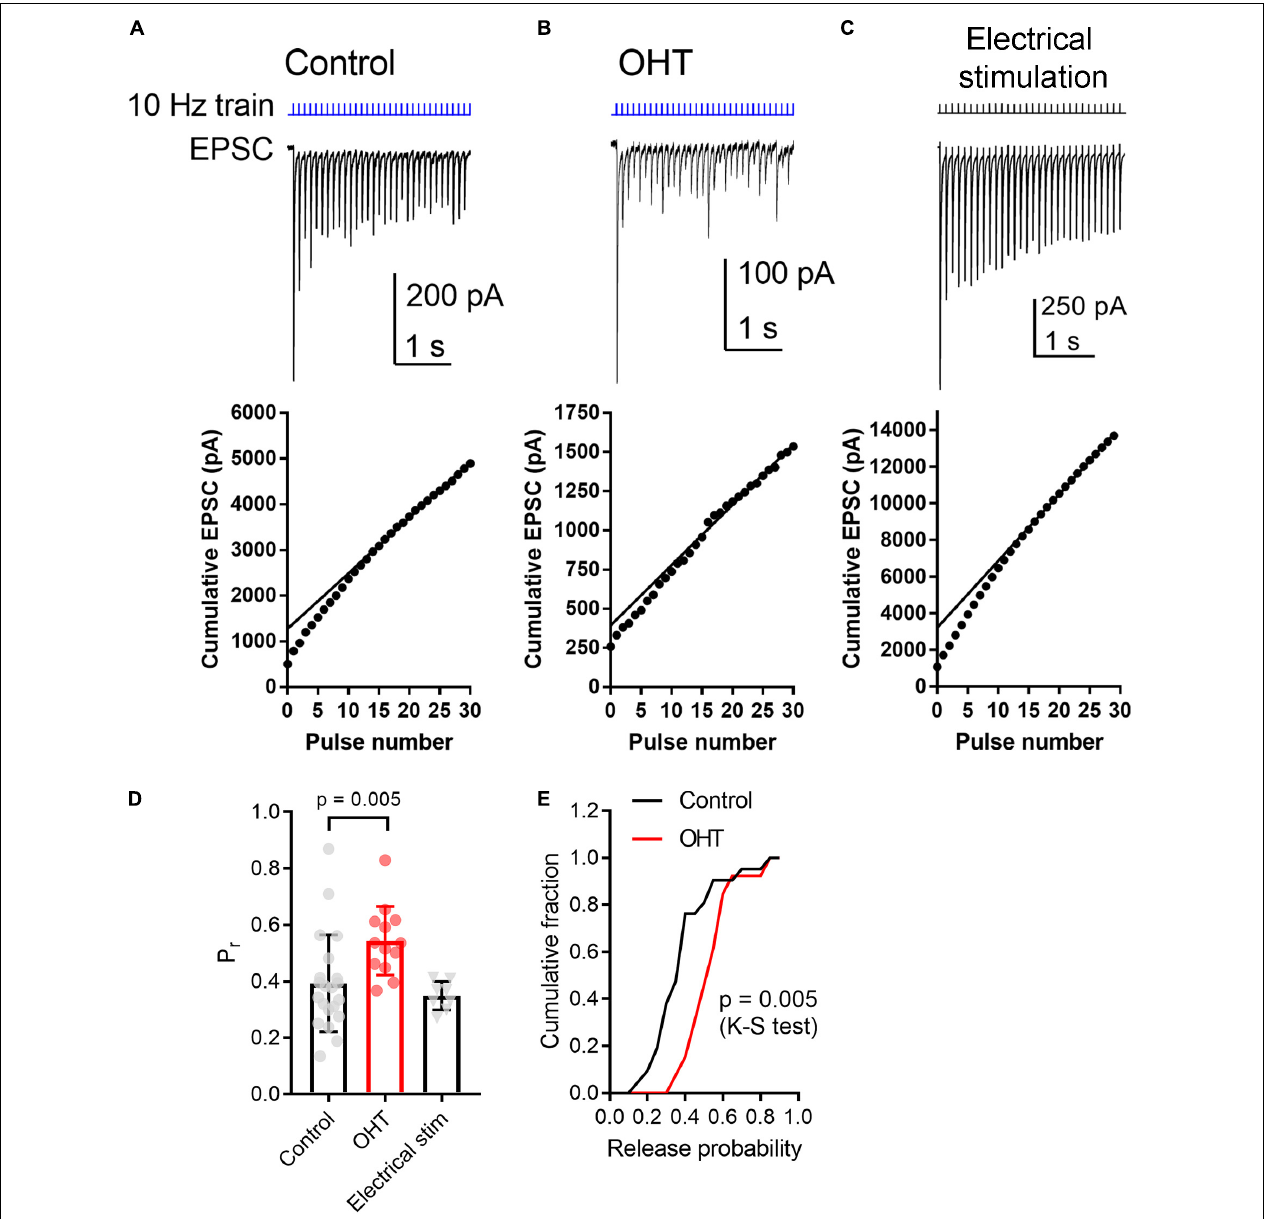
FIGURE 5 | OHT increases presynaptic vesicle release probability at retinogeniculate synapses. A train of LED stimuli (10 Hz, 30 stimuli) was used to assess synaptic vesicle release probability at RGC synapses onto TC neurons in control (A) and OHT (B) dLGN slices. Upper panels show the EPSC and lower panels show the cumulative EPSC with a straight line fit to stimuli 15–30 and extrapolated to the vertical axis. The ratio of the amplitude of the first EPSC to the vertical intercept of the fit is the release probability. (C) Responses to 10 Hz electrical stimuli delivered to the optic tract in parasagittal brain slices were similar to responses evoked by ChR2 stimulation in brain slices from saline-injected (control) mice. (D) The release probability (Pr) was elevated in recordings from OHT mice relative to recordings from saline-injected controls. The Pr measured from extracellular optic tract stimulation in parasagittal slices (“Electrical stim”) was similar to control values obtained with ChR2 stimulation. Values for each recorded cell are plotted individually and the bar graphs display mean + standard deviation. (E) Cumulative probability distribution of Pr values in control and OHT.